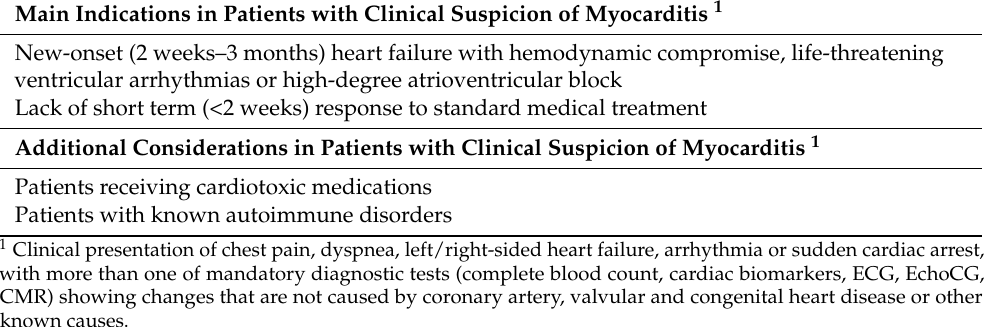
Table 3. Updated Dallas criteria for analysis of biopsy samples in suspected myocarditis [1,2]. Histological Criteria of Active Myocarditis Myocardial infiltration with mainly mononuclear cells, signs of non-ischemic myocyte necrosis, with or without fibrosis, at routine light microscopy Immunohistochemical Criteria Infiltrate containing ≥ 14 leukocytes/mm 2 , including up to 4 monocytes/mm 2 and